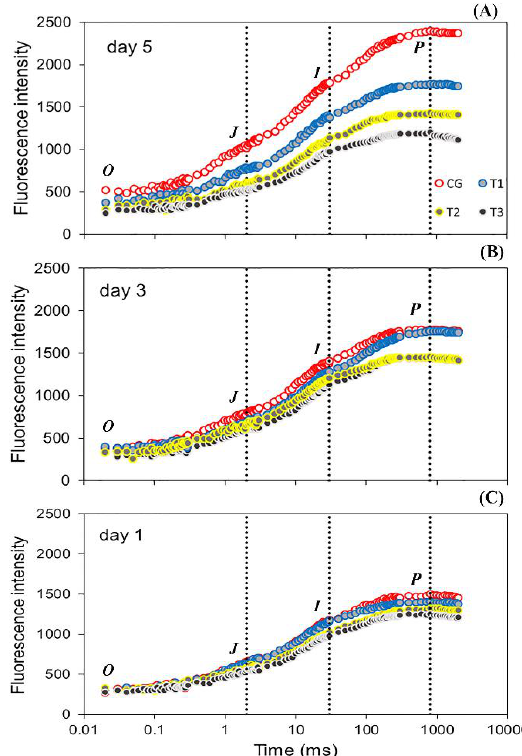
Figure 2. Representative OJIP curves for M. spicatum in each treatment on day 1 ( C ), 3 ( B ), and 5 ( A ). CG: control group; T1: 0.1 times of original decomposing liquid; T2: 0.2 times of original decomposing liquid; T3: 0.4 times of original decomposing liquid.